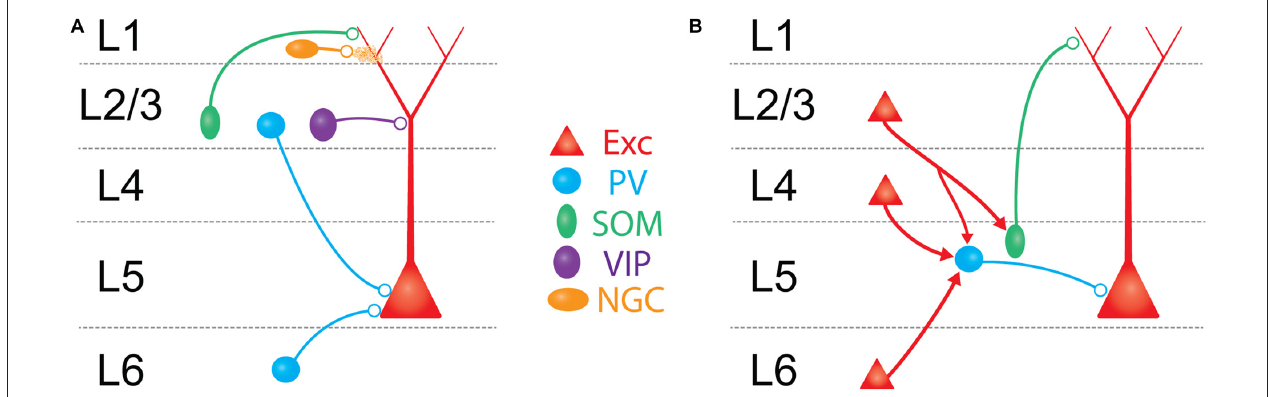
FIGURE 2 | Schematic overview of major translaminar inhibitory circuits impinging on L5 PCs. (A) Inhibition arises from multiple types of interneurons outside of L5. In L1, 5HT3aR/Neurogliaform cells (NGCs, mustard) inhibit L5 PCs via volume release of GABA. In L2/3, SOM/Martinotti cells (green) and VIP cells (purple) target the apical dendrites of L5 PCs, while PV/basket cells (blue) synapse onto the perisomatic compartment via descending axons. In L6, translaminar PV/basket cells inhibit L5 PCs via ascending axons. (B) Excitatory translaminar pathways recruit L5 interneurons. Excitatory cells in L2/3, L4, and L6 can target PV/basket cells. Additionally, L2/3 PCs synapse onto L5 SOM/Martinotti